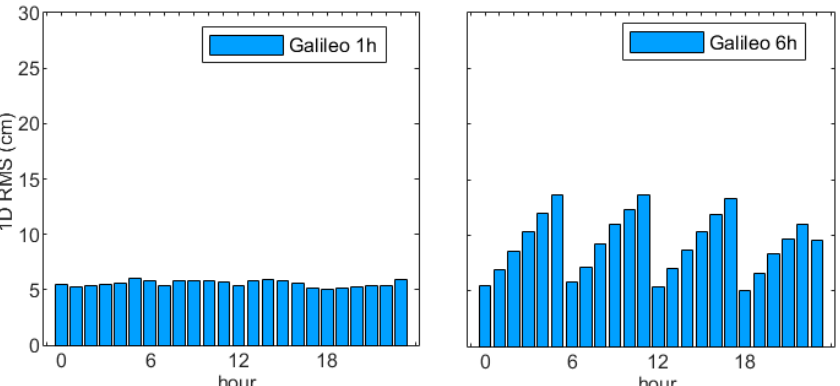
Figure 9. Accuracy of Galileo ultra-rapid predicted orbit updated per 6 h and Galileo ultra-rapid predicted orbit updated per 1 h.